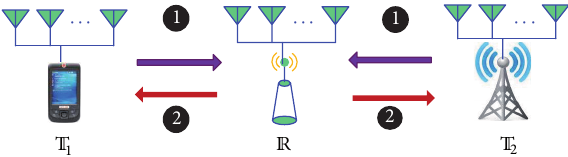
Figure 1: MIMO-OFDM-TWRN: (1) multiaccess stage, (2) broad- casting